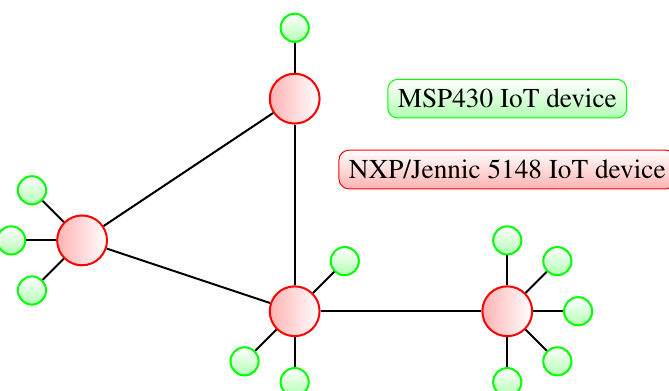
Figure 1. Extended star topology representation of a small heterogeneous IoT network with MSP430- and NXP/Jennic 5148-based IoT devices.